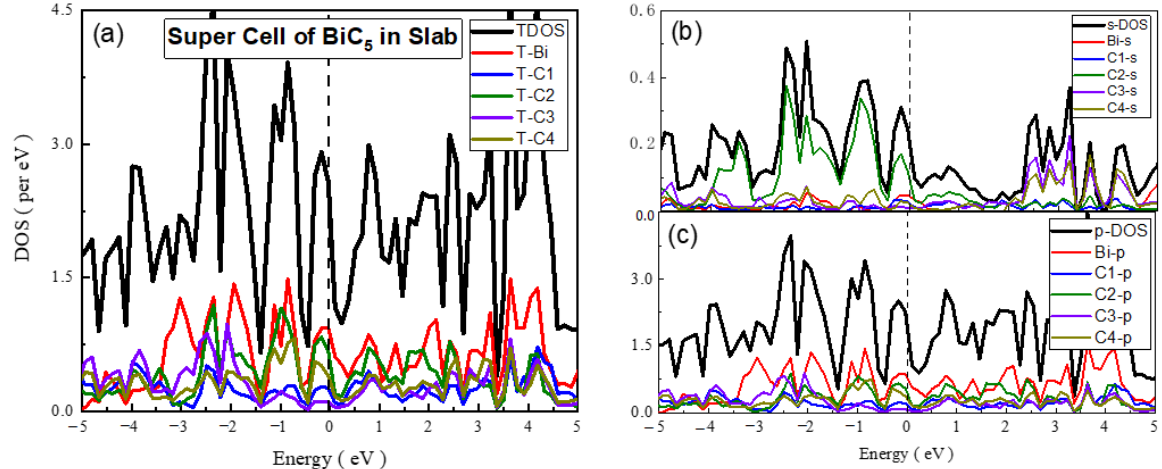
Figure 9. The calculated total density of states (TDOS) and partial density of states for mentioned atoms in BiC 5 Super cell ( a ) TDOS of slab ( b ) s-DOS of slab ( c ) p-DOS of slab. The Fermi level was adjusted at 0 eV.